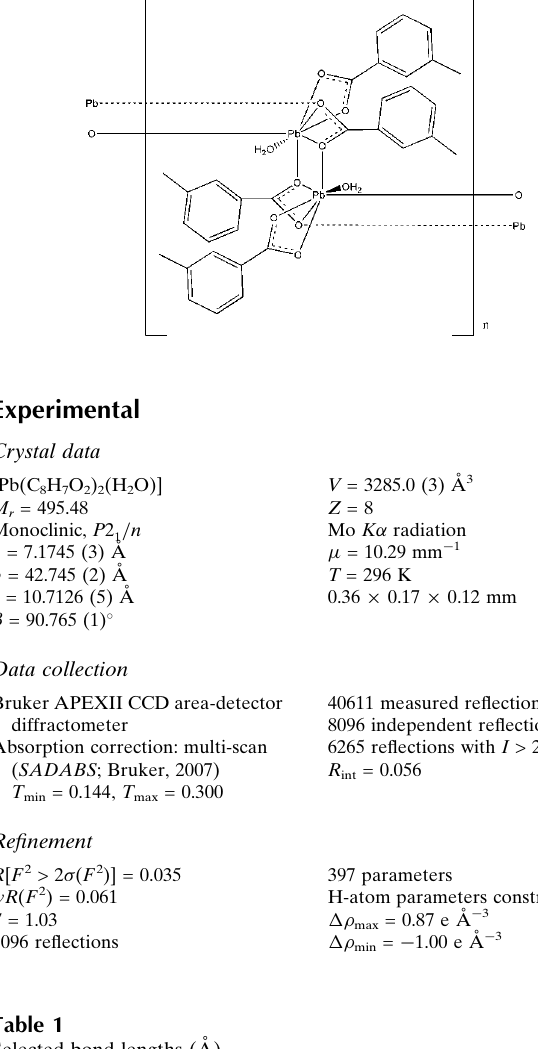
Selected bond lengths (A˚ ).